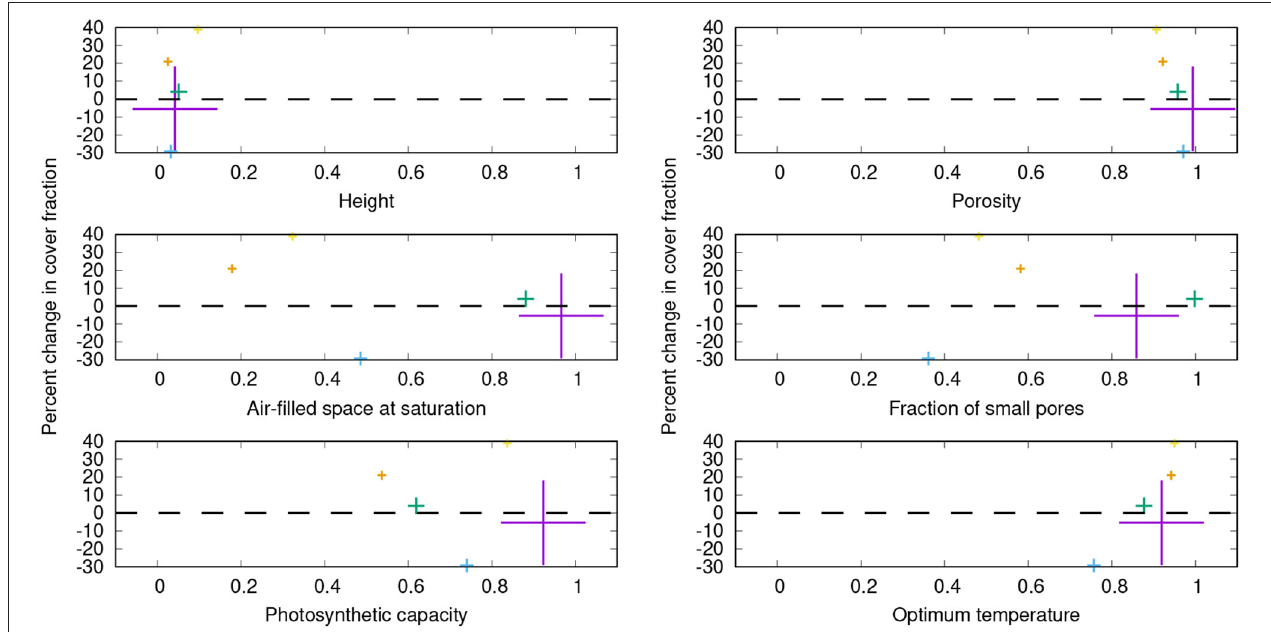
FIGURE 8 | Percent changes in share on the total cover for the five physiological strategies which have the largest relative cover values in the control simulation, resulting from switching off the bark reservoir in LiBry. The color denotes the individual strategies, and the size of the crosses is proportional to the share of the strategy on the total cover. The dominant strategy (purple) has a share of 31% on the total cover in the control simulation. On the x-axes, a subset of the physiological parameters is shown which define a strategy in the LiBry model. The values of these parameters are normalized to the range between 0 and 1, where 0 corresponds to the lowest value and 1 to the highest value used in LiBry, based on the literature (Porada et al.,